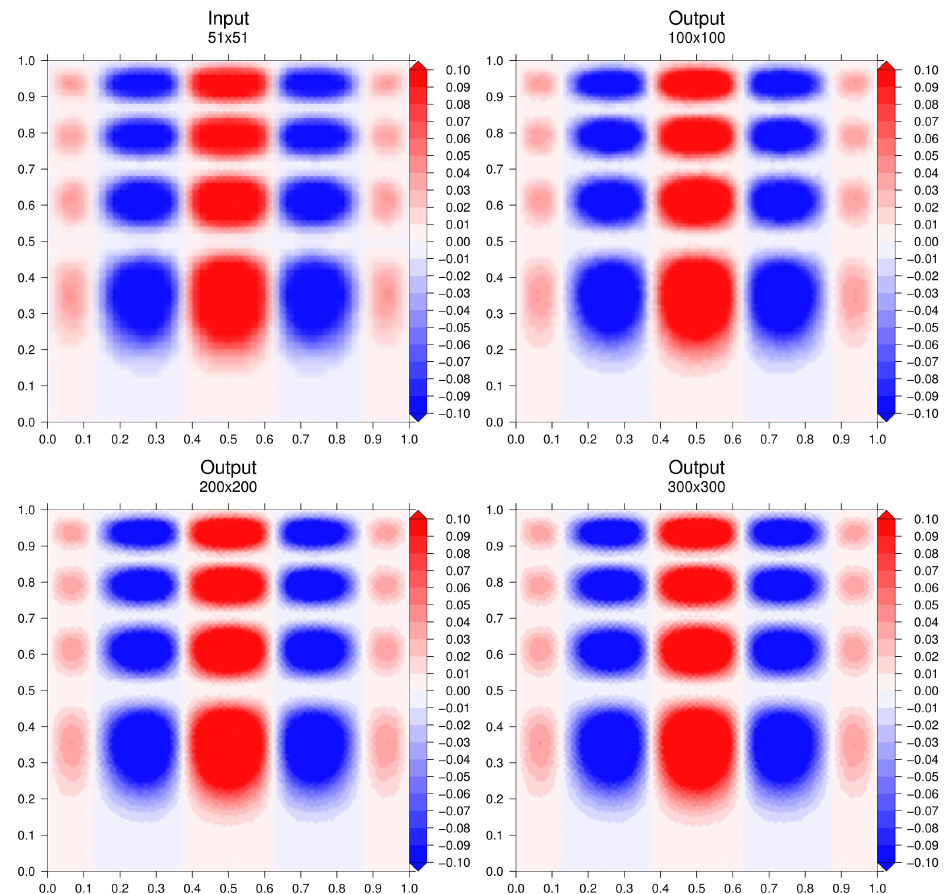
Figure 3. Interpolation results for the three cases. Figures were generated with the Generic Mapping Tools (Wessel et al.,